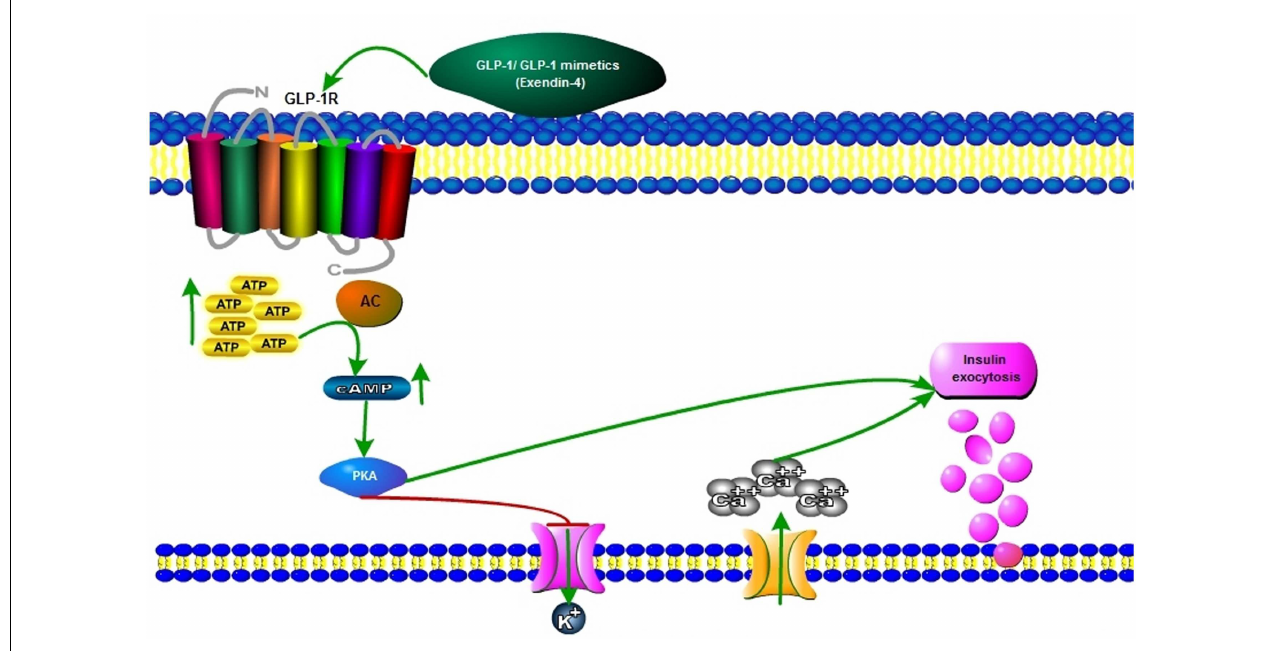
membrane depolarizes, allowing calcium influx to occur via the voltage-dependent calcium channels (VDCC) and culminating in calcium-dependent insulin exocytosis. Alternatively, insulin secretion may be also stimulated by intracellular signaling cascades involving, e.g., cyclic AMP (cAMP) or its downstream targets Epac (exchange protein activated by cAMP), protein kinase A (PKA), AMP kinase (AMPK), protein kinase C (PKC), or MAPK. As blood glucose levels return to normal, GLP-1-induced insulin exocytosis is